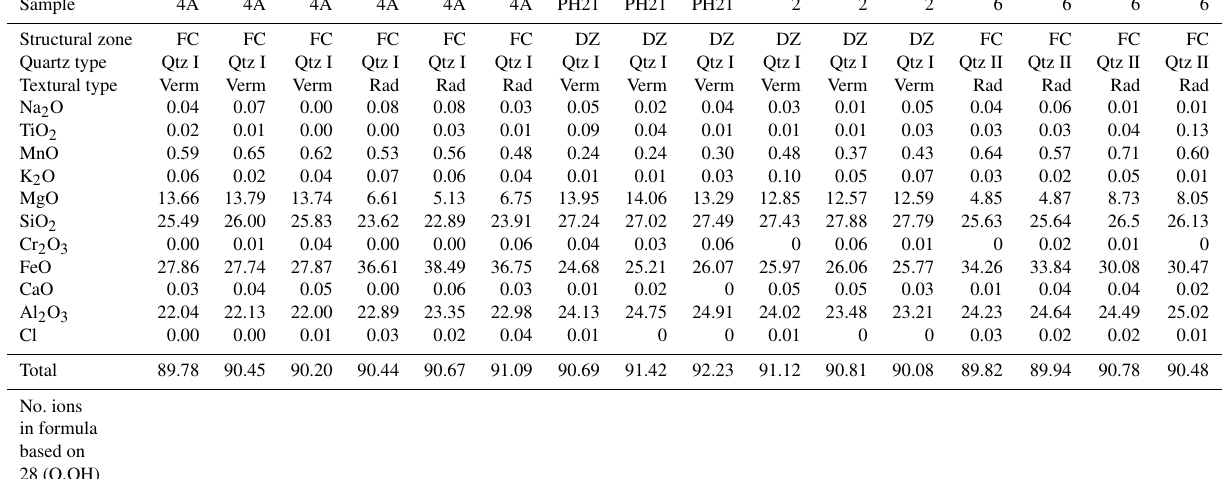
Table 2. Representative chlorite EPMA from various structural zones of BFZ300.